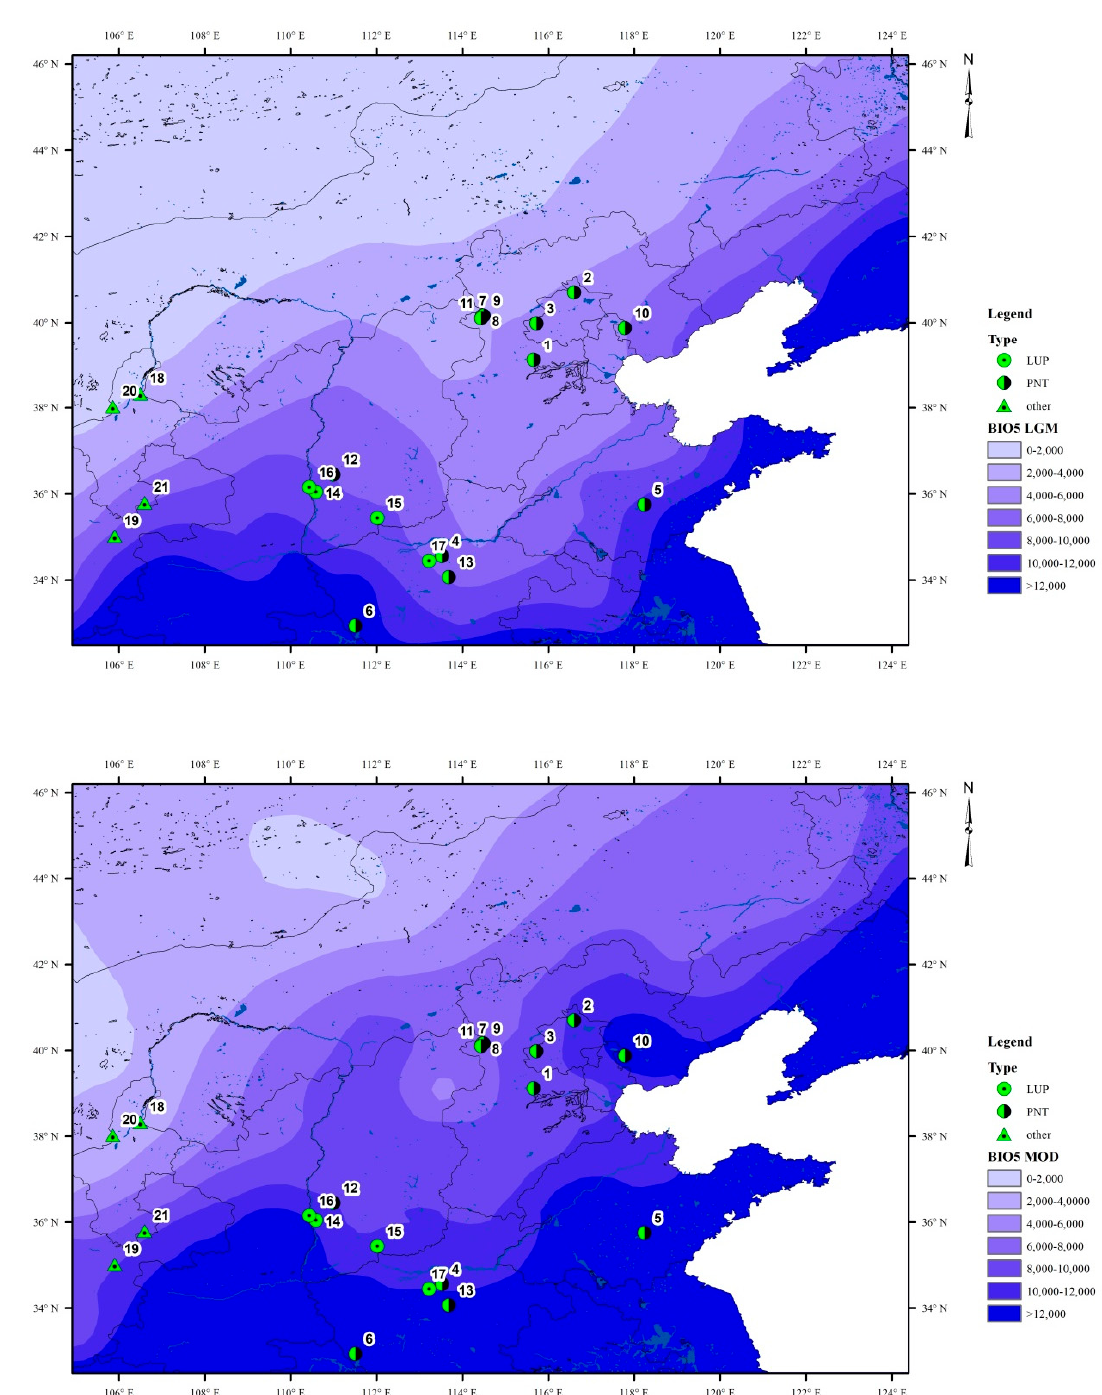
Figure 5. Archaeological sites dated to the Pleistocene to Holocene transition on the maps of primary biomass (BIO5) of Northern China under LGM and modern climatic conditions.